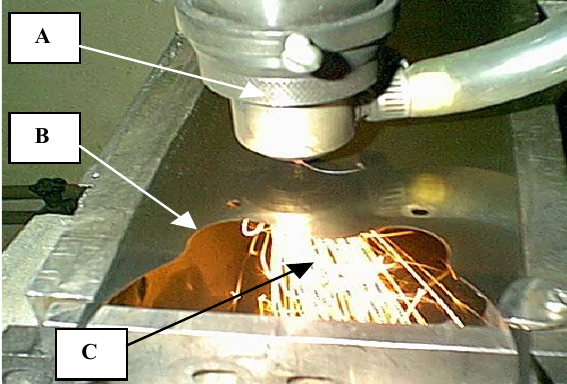
Fig 4. Particle generation and laser cutting device: A - nozzle (lens orifice), B - the work piece contour, C - gas (air) and particle flow out flowing from the cut